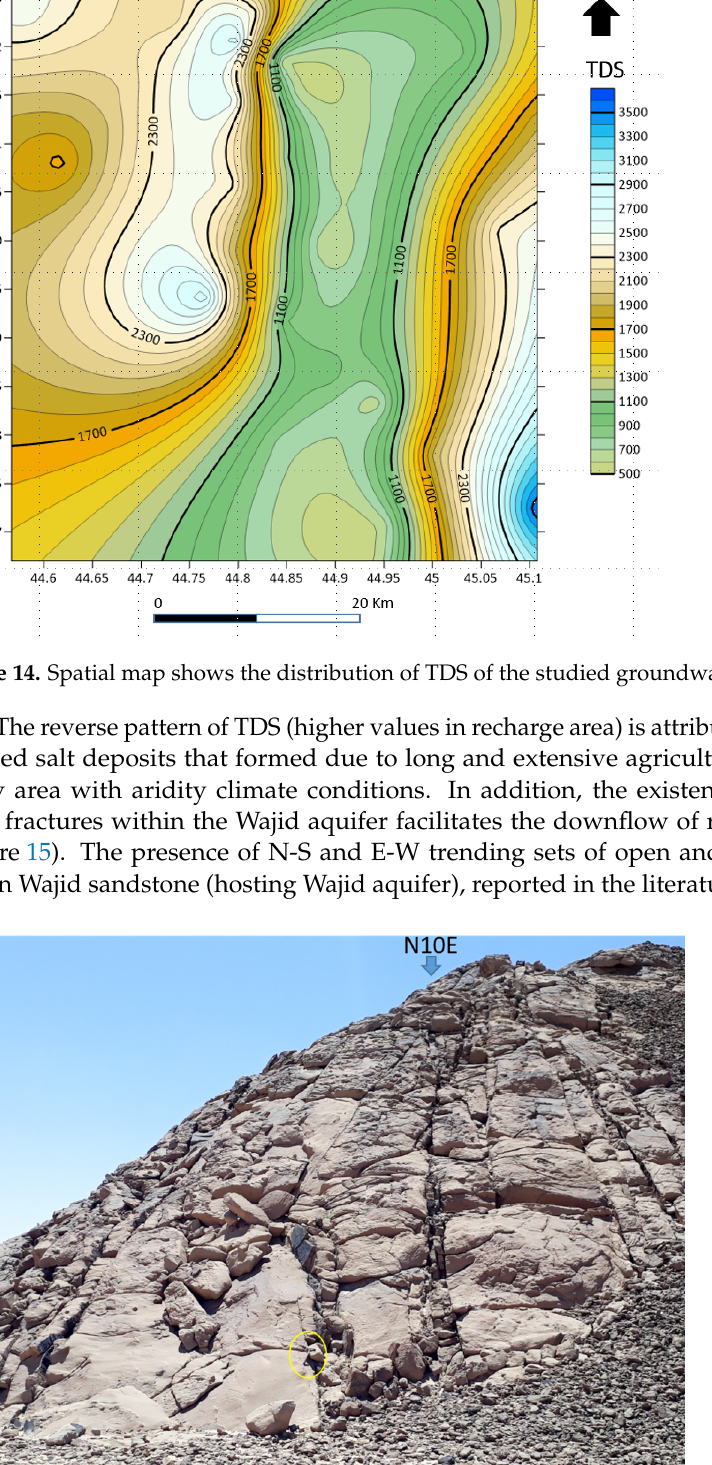
Figure 15. Photograph shows the N10 E-trending fracture set within the Wajid sandstone outcrop close to an agricultural area, Wadi Al-Dawasir.